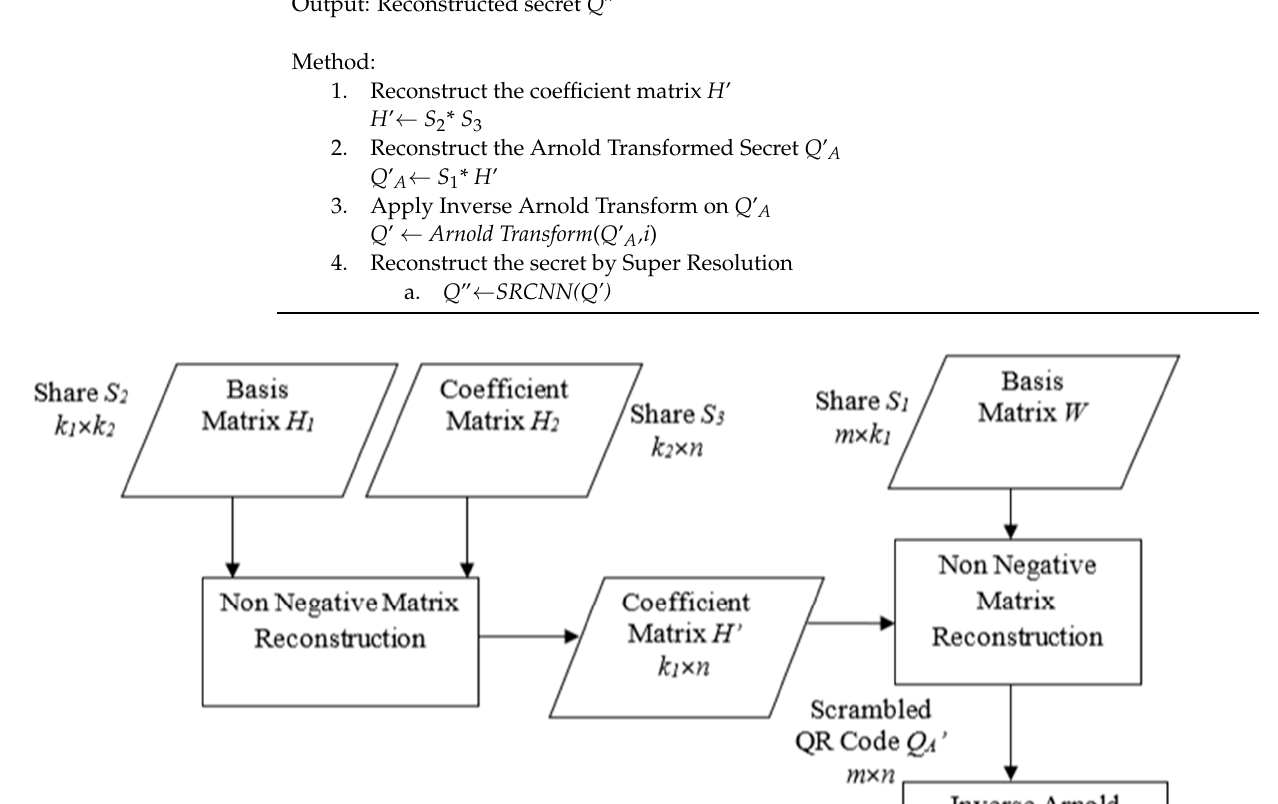
Algorithm 2. Secret Reconstruction